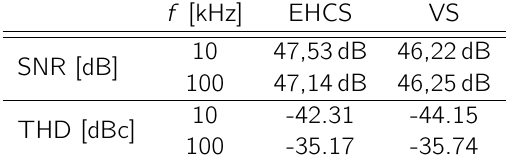
Table 2: SNR and THD of the hardware realization.